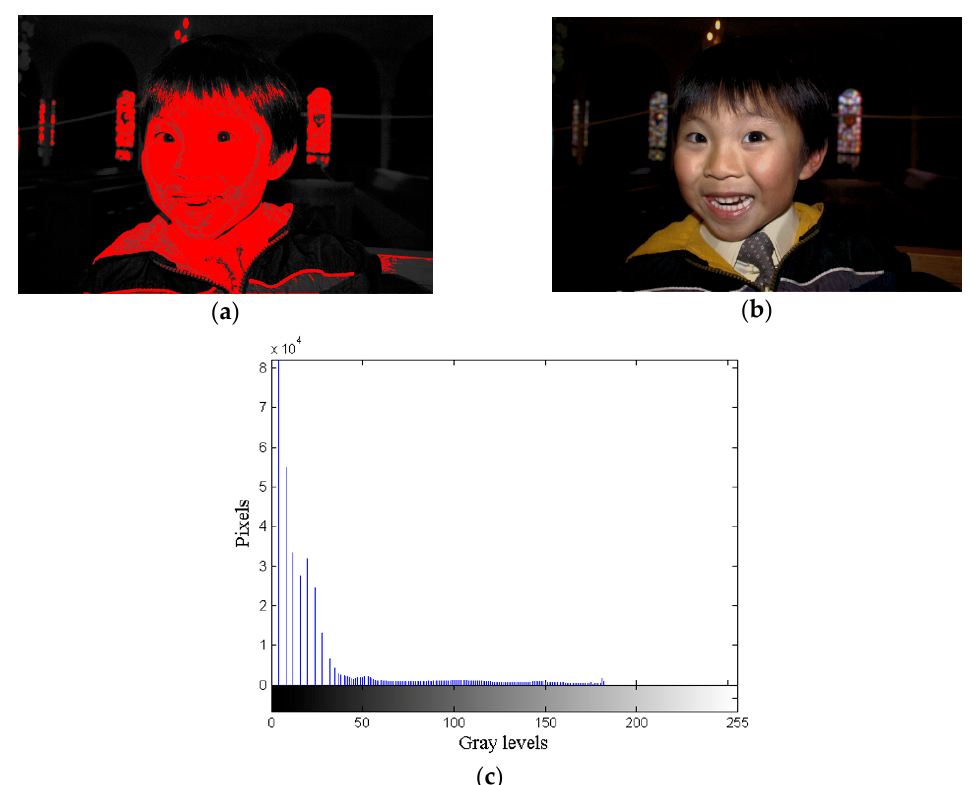
Figure 5. GVR results for Daniel image, ( a ) Regions of compressed gray values; ( b ) GVR image; ( c ) GVR histogram.